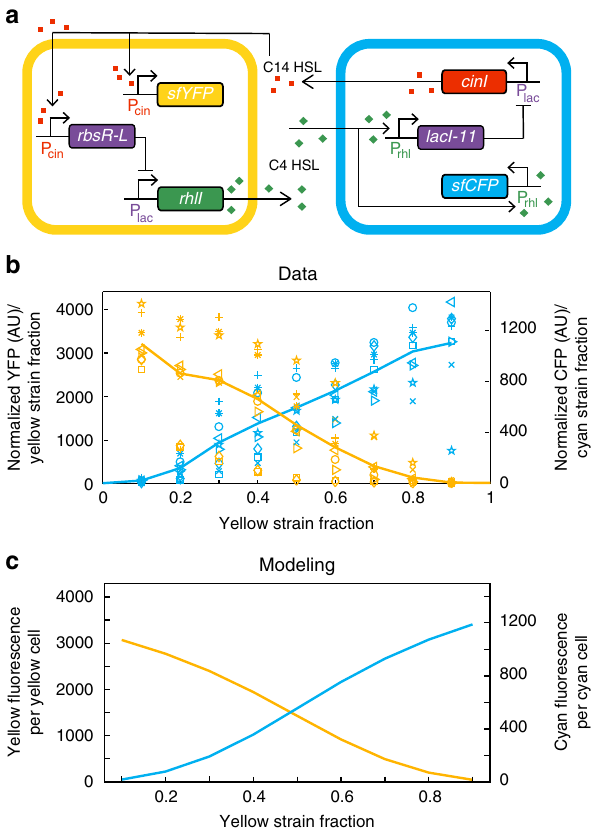
Fig. 5 Minority wins pattern. a Genetic circuit of the minority wins consortium. b Quanti fi cation of the fl uorescence intensities of the minority wins consortium at mixtures of the two strains with 10% increments from 100% cyan strain to 100% yellow strain from liquid cultures in a 96-well plate ( n = 9). Data are normalized to strain fraction to account for any change in fl uorescence due to the decrease in the number of cells containing the fl uorescence gene. Same symbols with different colors represent the yellow and cyan intensities from the same well of the same replicate experiment and lines represent averages across all replicates. Source data are provided as a Source Data fi le. c Modeling of minority wins consortium fl uorescence as a function of yellow strain fraction. The model and data qualitatively agree, and both demonstrate the inverse relationship between strain fraction and fl